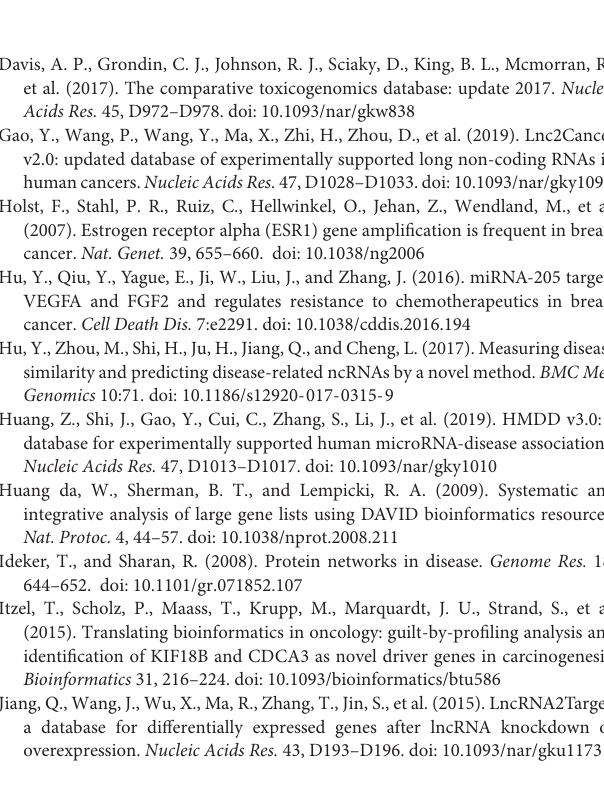
TABLE S1 | The list of common CRN. TABLE S2 | The list of BC-specific CRN. TABLE S3 | The list of 177 seed BC factors. TABLE S4 | Prioritization of all candidate factors. TABLE S5 | The top 100 ranked candidate BC-associated factors validated by recently published articles. TABLE S6 | The list of significantly DE TFs, PCGs, miRNAs and lncRNAs in BC (adjusted P -value < 0.05 and | log2FC| >